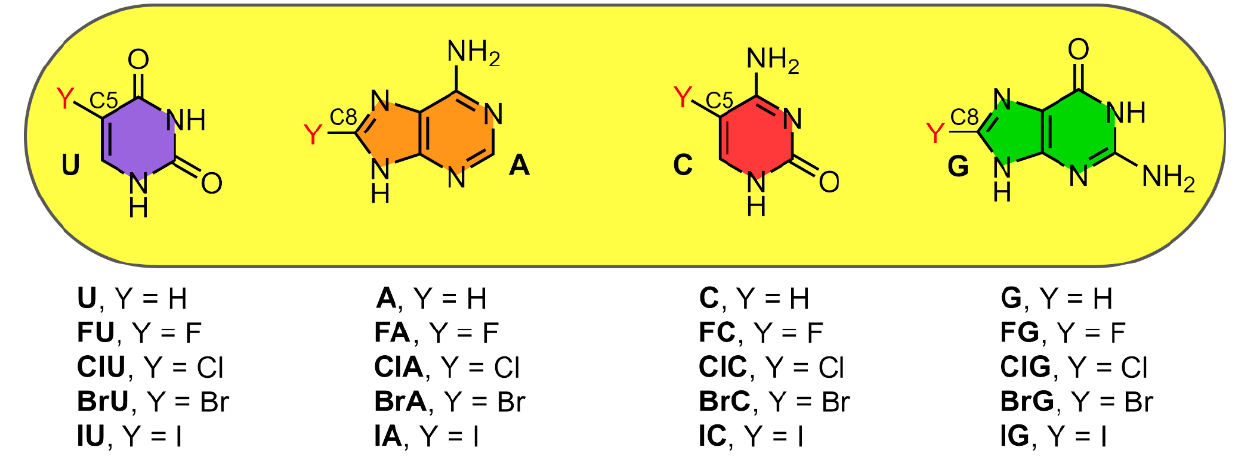
Figure 2. Schematic representation of the nucleobases Uracil (U), Adenine (A), Cytosine (C), and Guanine (G) and their corresponding halogenated derivatives at the C5 and C8 positions used in this study.